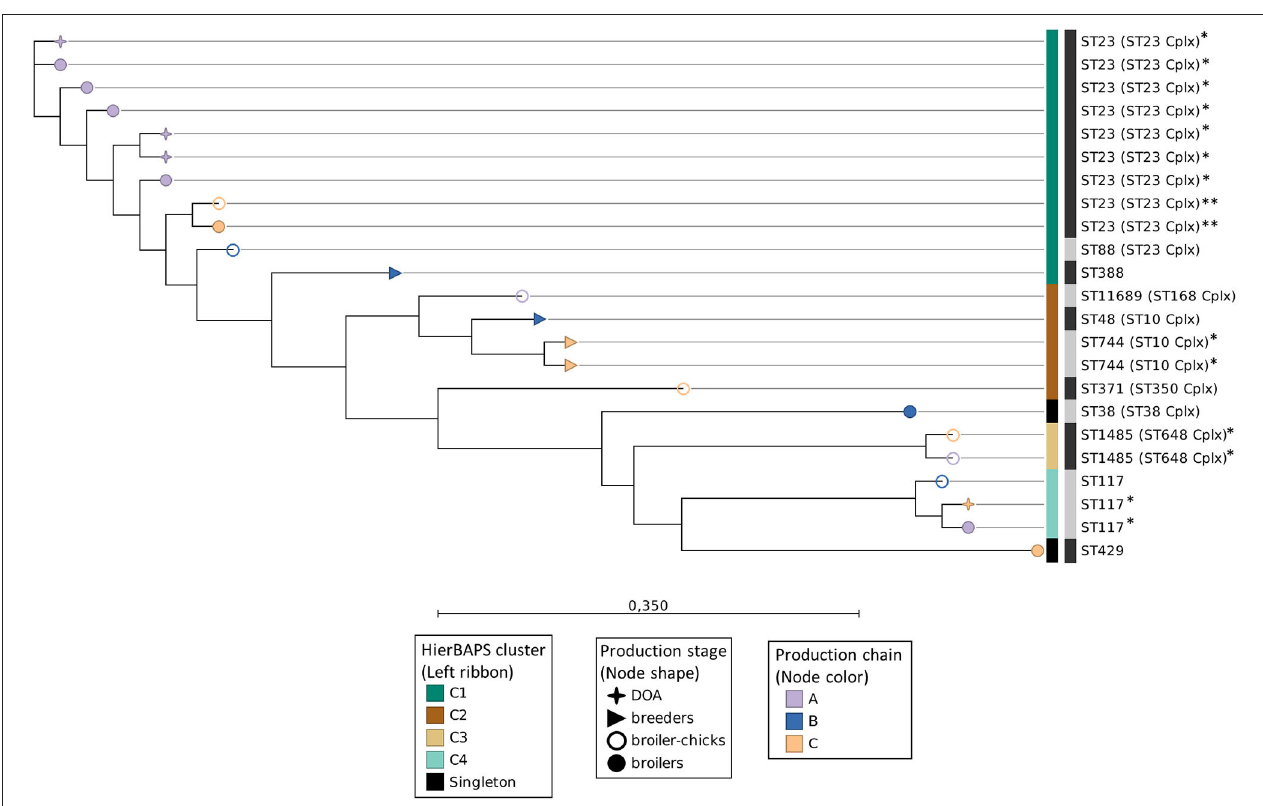
FIGURE 4 | Maximum-likelihood SNP-based phylogeny of APEC whole-genome sequences. Nodes’ shape and color indicate the broiler production stage and production chain, respectively. The left, colored ribbon specifies the hierBAPS clusters. The right ribbon with alternating dark and light gray segments, marks different STs. Isolates belonging to the same ST and indicated with the same number of asterisks (*) differed by < 50 SNPs. Scale bar refers to the branch lengths, which are measured in the number of substitutions per